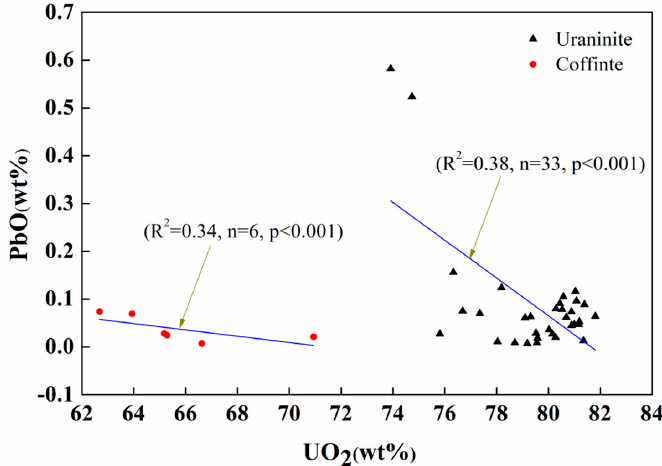
Figure 12. PbO–UO 2 correlation trend of uraninite and coffinite grains.